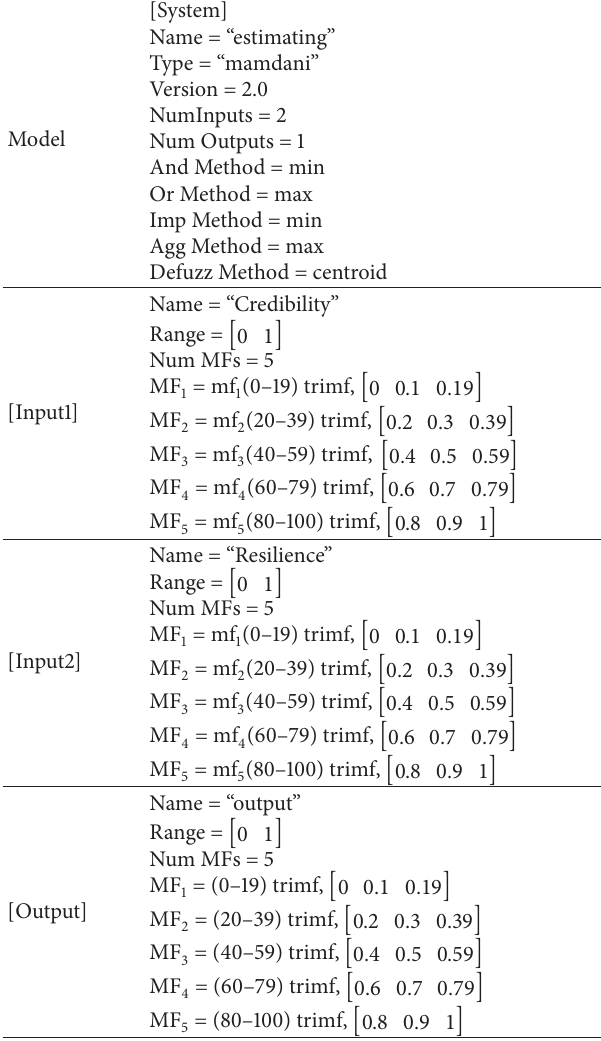
Table 2: Proposed model (inputs and